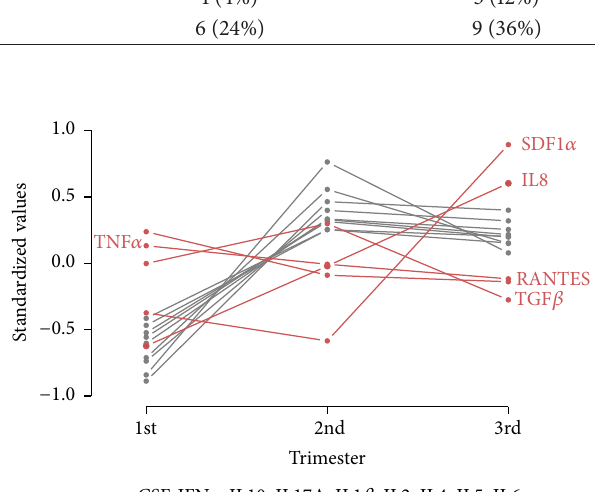
Figure 1: Evolution of the levels of each cytokine throughout pregnancy in the three study groups. Cytokine concentrations were expressed as standardized values (mean = 0, SD = 1). RANTES, regulated upon activation normal T-cell expressed and secreted; TNF 𝛼 , tumor necrosis factor-alpha; TGF 𝛽 , transforming growth factor-beta; IL8, interleukin 8; and SDF1 𝛼 , stromal cell-derived factor 1